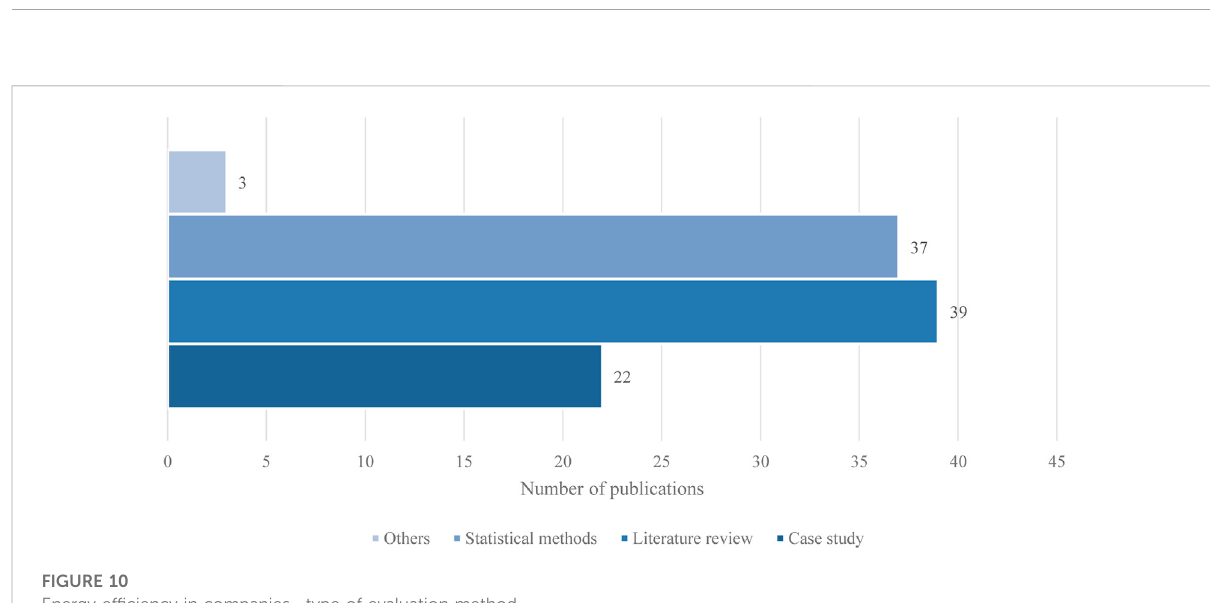
FIGURE 10 Energy ef fi ciency in companies — type of evaluation method.